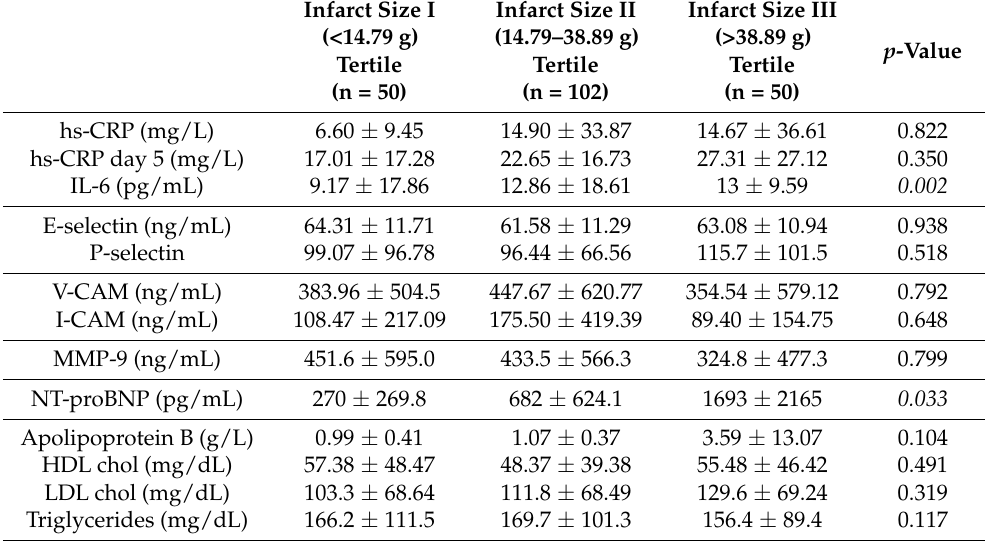
Table 3. Serum biomarker levels of the study groups.